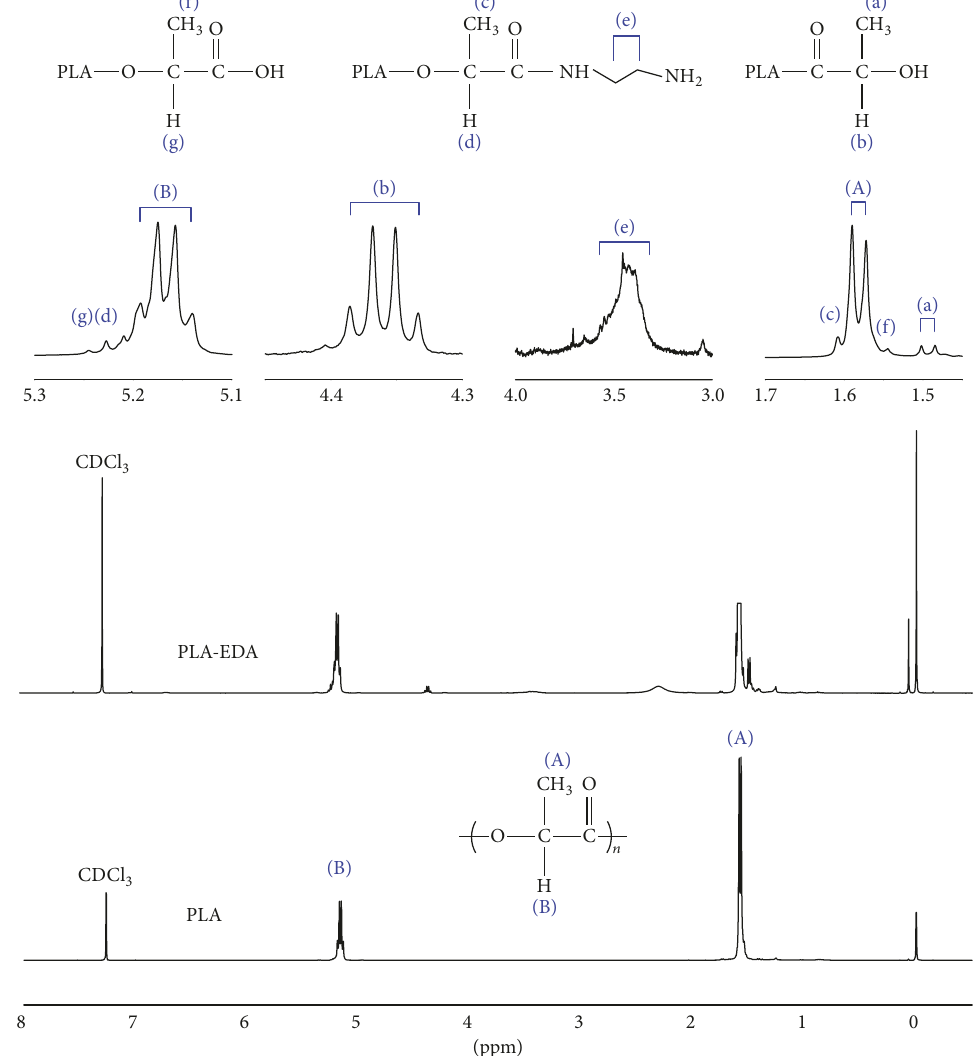
Figure 2: 1 H NMR spectra of raw PLA and PLA-EDA in CDCl 3 . Aminolysis condition of PLA with EDA: 30 ∘ C, 30 min, [EDA] = 1.0